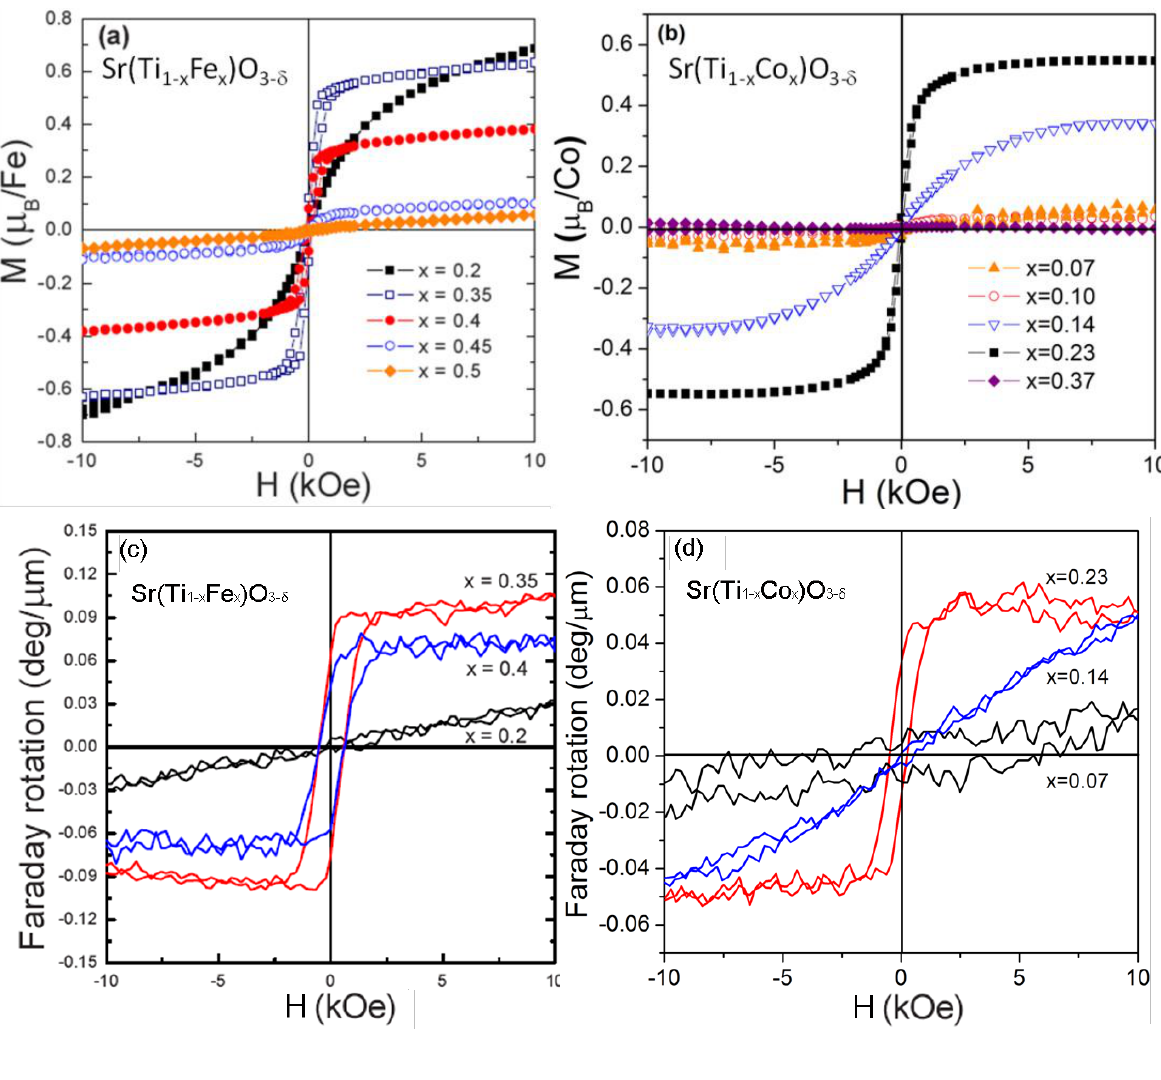
Figure 3. Room temperature out-of-plane magnetization hysteresis of ( a ) STF and ( b )